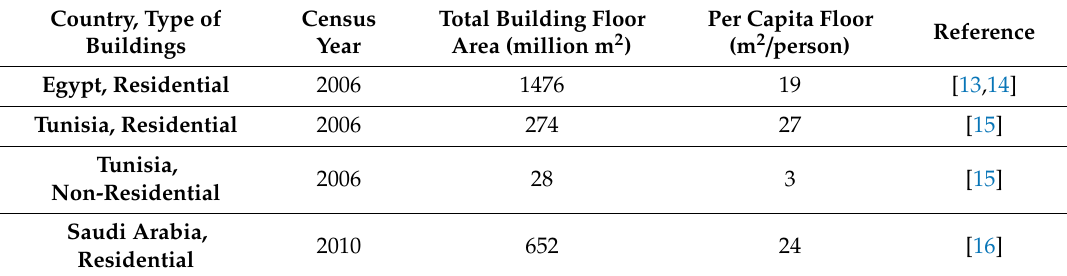
Table 3. Reported total floor area for buildings in Arab countries based on census data.